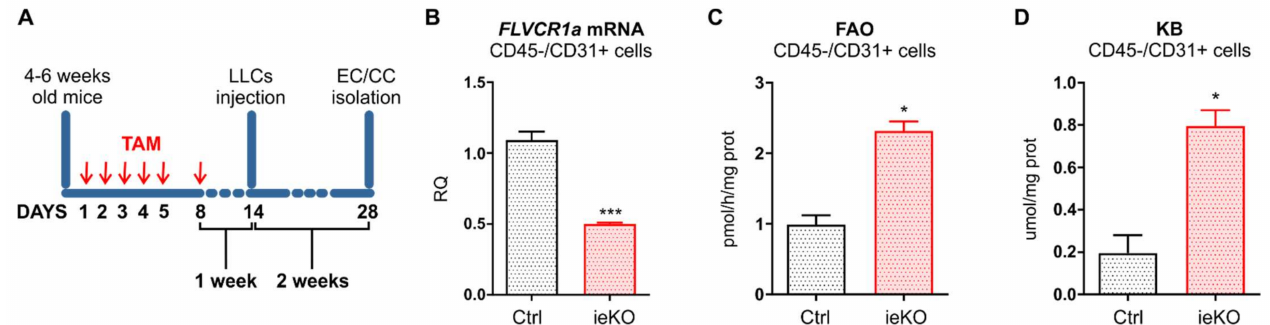
Figure 3. Metabolic changes found in TECs isolated from LLC-xenografts developed into Flvcr1a iEC-KO mice. ( A ) Schematic representation of tamoxifen (TAM) treatment in Flvcr1a flox/flox ; Cdh5(PAC)-Cre ERT2 and Flvcr1a flox/flox control mice. Briefly, 4–6 weeks old mice were treated intraperitoneally with 1 mg/day tamoxifen for 5 consecutive days, followed by 1 additional day after a 2-day treatment-free interval (red arrows). After one week after TAM injection, 5 × 10 5 LLC cells suspended in 100 µ L PBS were injected subcutaneously into the mice flanks. Tumors were dissected after 12–14 days from LLC cells injection. ( B ) qRT-PCR analysis showing Flvcr1a mRNA levels in CD45 − /CD31+ cells isolated from LLC xenografts developed in Flvcr1a iEC-KO (ieKO) and control (Ctrl) mice. Data represent means ± SEM, n = 3. For statistical analyses, an unpaired Student’s t -test was used. *** p < 0.001. ( C , D ) FAO and β -OH levels measured in CD45 − /CD31+ cells isolated from LLC xenografts developed in Flvcr1a iEC-KO (ieKO) and control (Ctrl) mice. FAO values are expressed as pmol of 14C-acid-soluble metabolites (14C-ASM)/h/mg of proteins. β -OH levels are expressed as µ mol/mg of cellular proteins. The measure of β -OH was considered as an index of KBs amount. Data represent means ± SEM, n = 2 pools of animals. For statistical analyses, an unpaired Student’s t -test was used. * p < 0.05. EC, endothelial cell; CC, cancer cell; FAO, fatty acid β -oxidation; KB, ketone